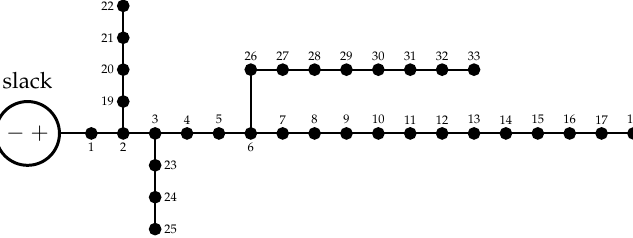
Figure 10. Electrical configuration for the 33-nodes test system (taken from